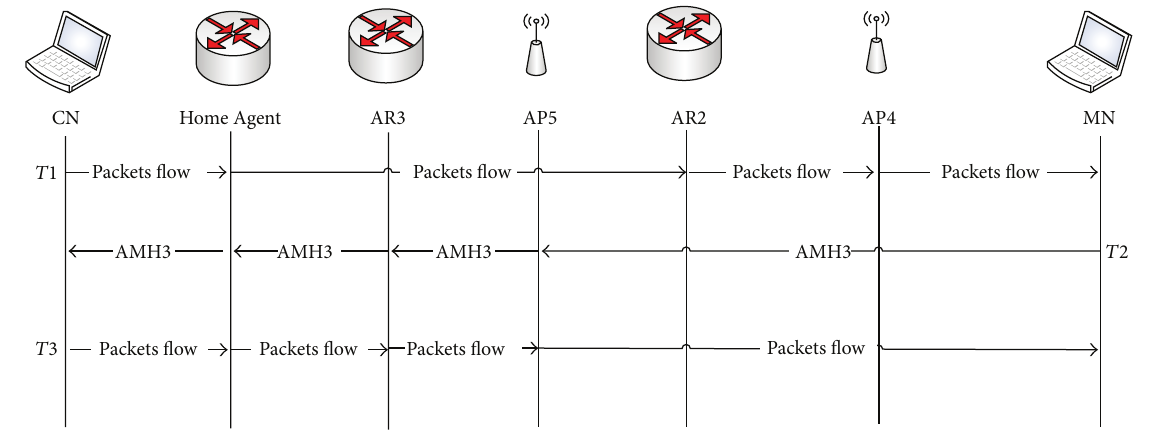
Figure 6: AMH3 scheme within different subnets and different global routing prefixes. Table 4: Data updating in each of AP and AR with different global routing prefix, HA, and CN after AMH3 message. AP5 entry table after T2 AR3 entry routing table after T2 HA&CN entry routing table after